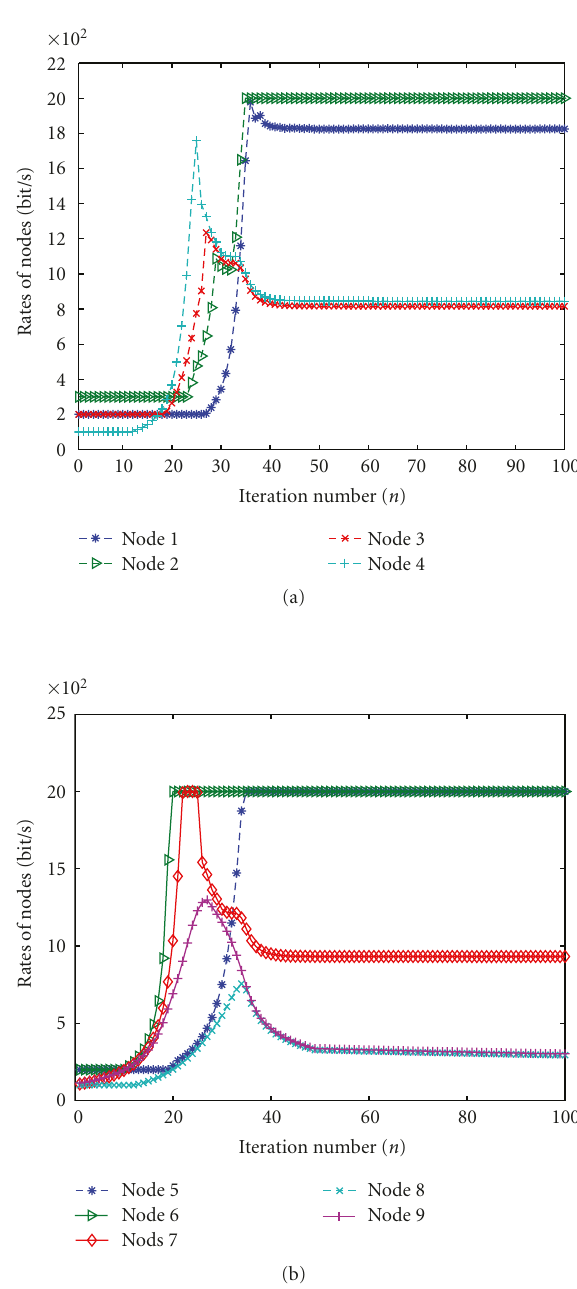
Figure 5: Convergence of the ASMOP algorithm by using hierar- chical sequence